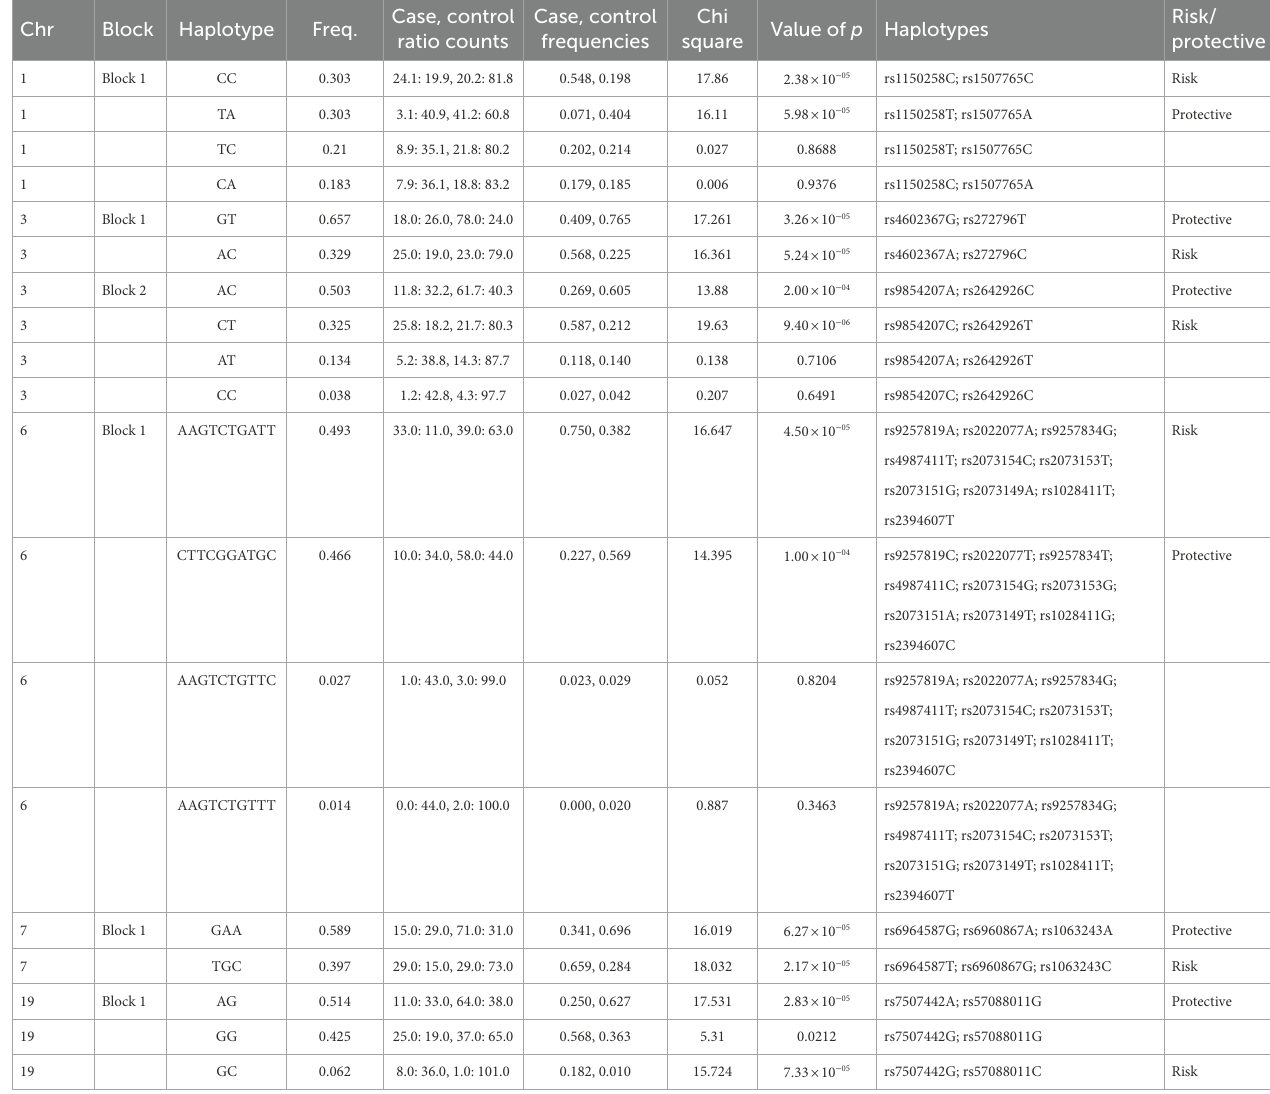
TABLE 3 Haplotype blocks of SNPs with significant p < 0.0001 in Saudi autistic females. Chr Block Haplotype Freq.